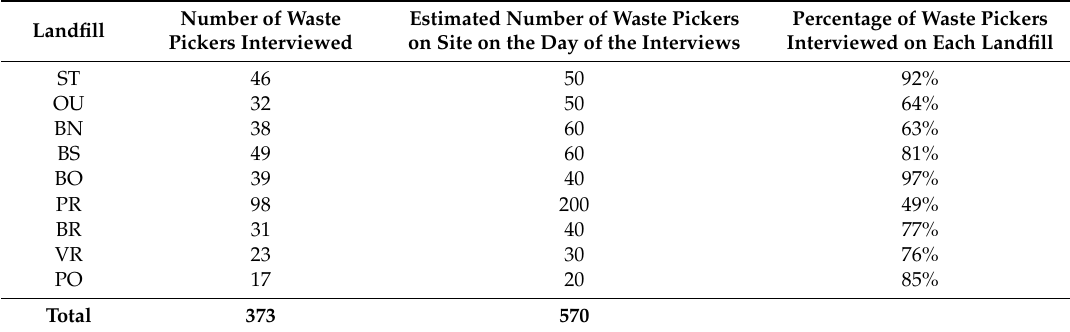
Table 2. Number of interviews conducted on each landfill *.